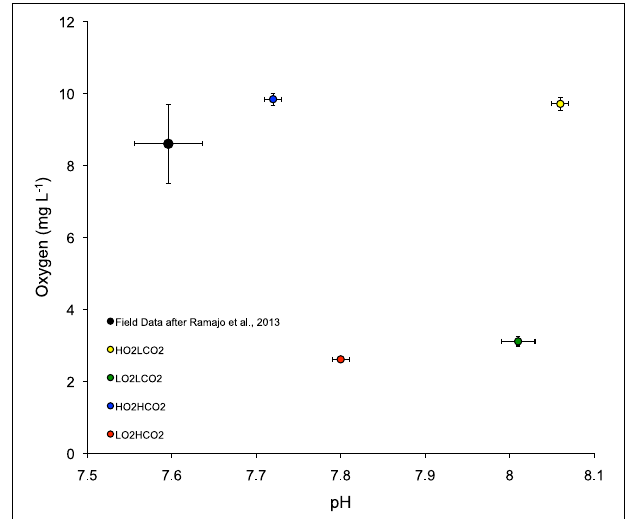
FIGURE 6 | The experimental range of variables from this experiment compared to the ecosystems ambient range of oxygen and pH from the study sites in central and southern Chile during November 2009 and January 2010 (Ramajo et al., 2013).